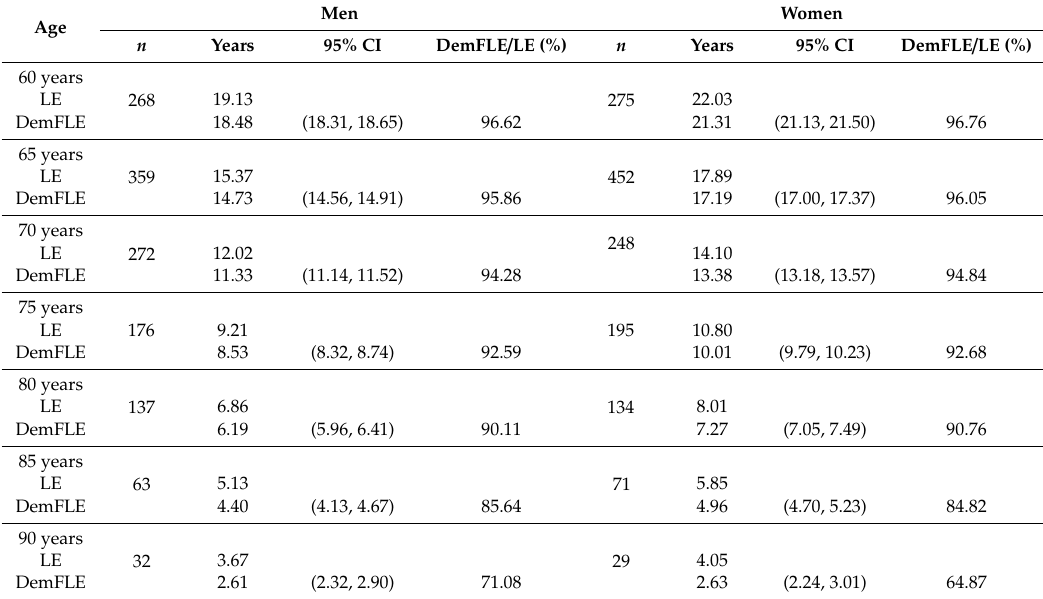
Table 1. LE, DemFLE, and the proportion of DemFLE in Jiangxi province, China, by sex and selected ages for the year